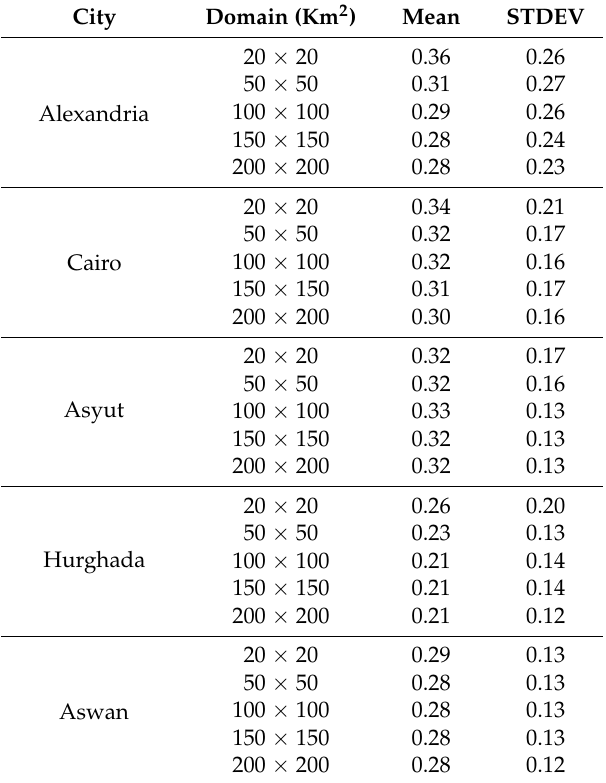
Table 7. Mean and standard deviation of AOD (average over the 12-year period) from the successive spatial domains over the five cities. City Domain (Km 2 ) Mean STDEV